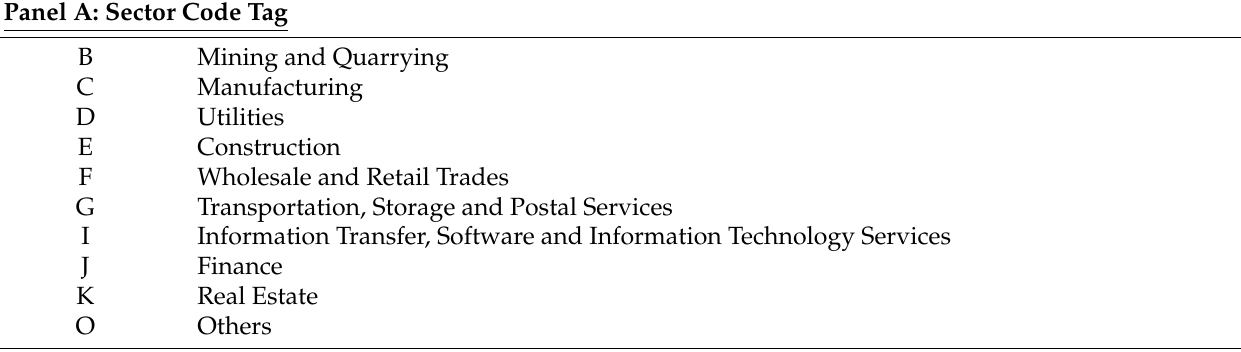
Table 8. Sector portfolios of MSCI China